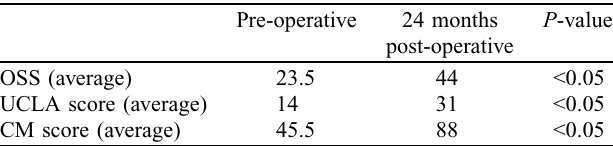
Table 1. Primary outcome measures (shoulder scores) 24 months post-operative.